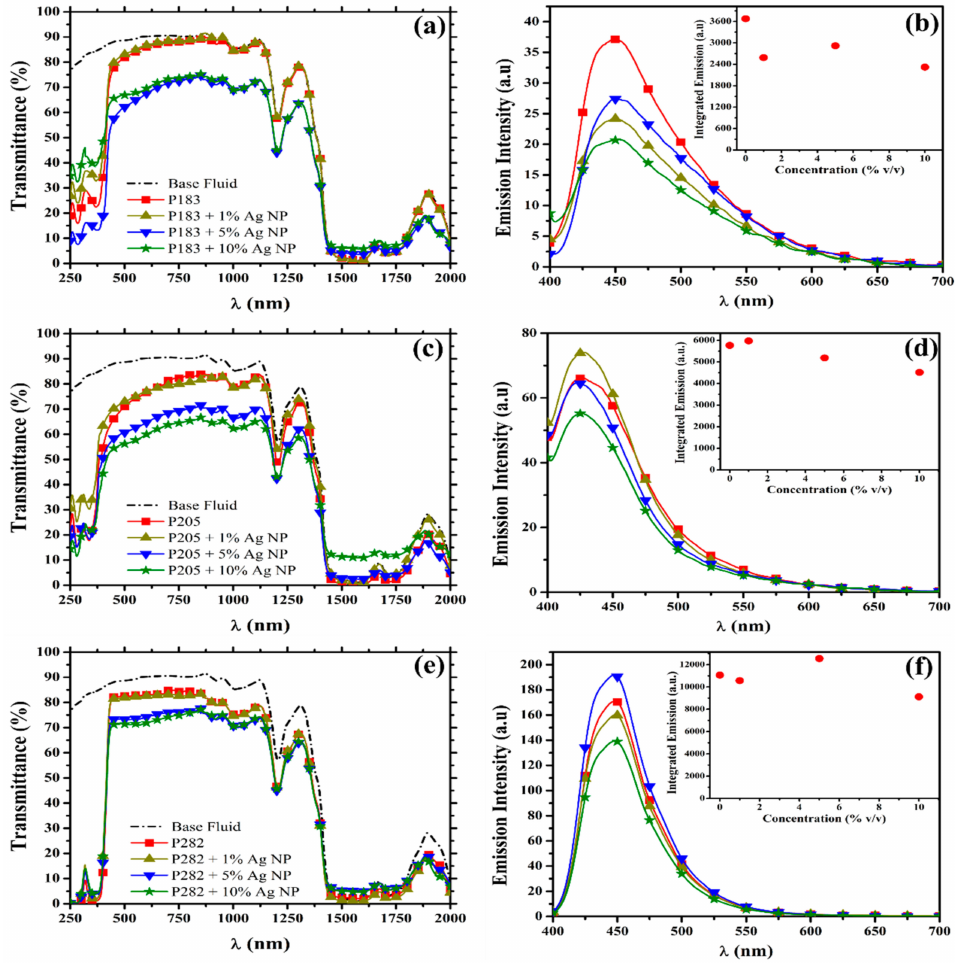
Figure 2. Experimentally determined optical transmittance of ( a ) P183, ( c ) P205 and ( e ) P282 loaded ethylene glycol based PLDS nanofluids at di ff erent Ag nanoparticles concentration. The